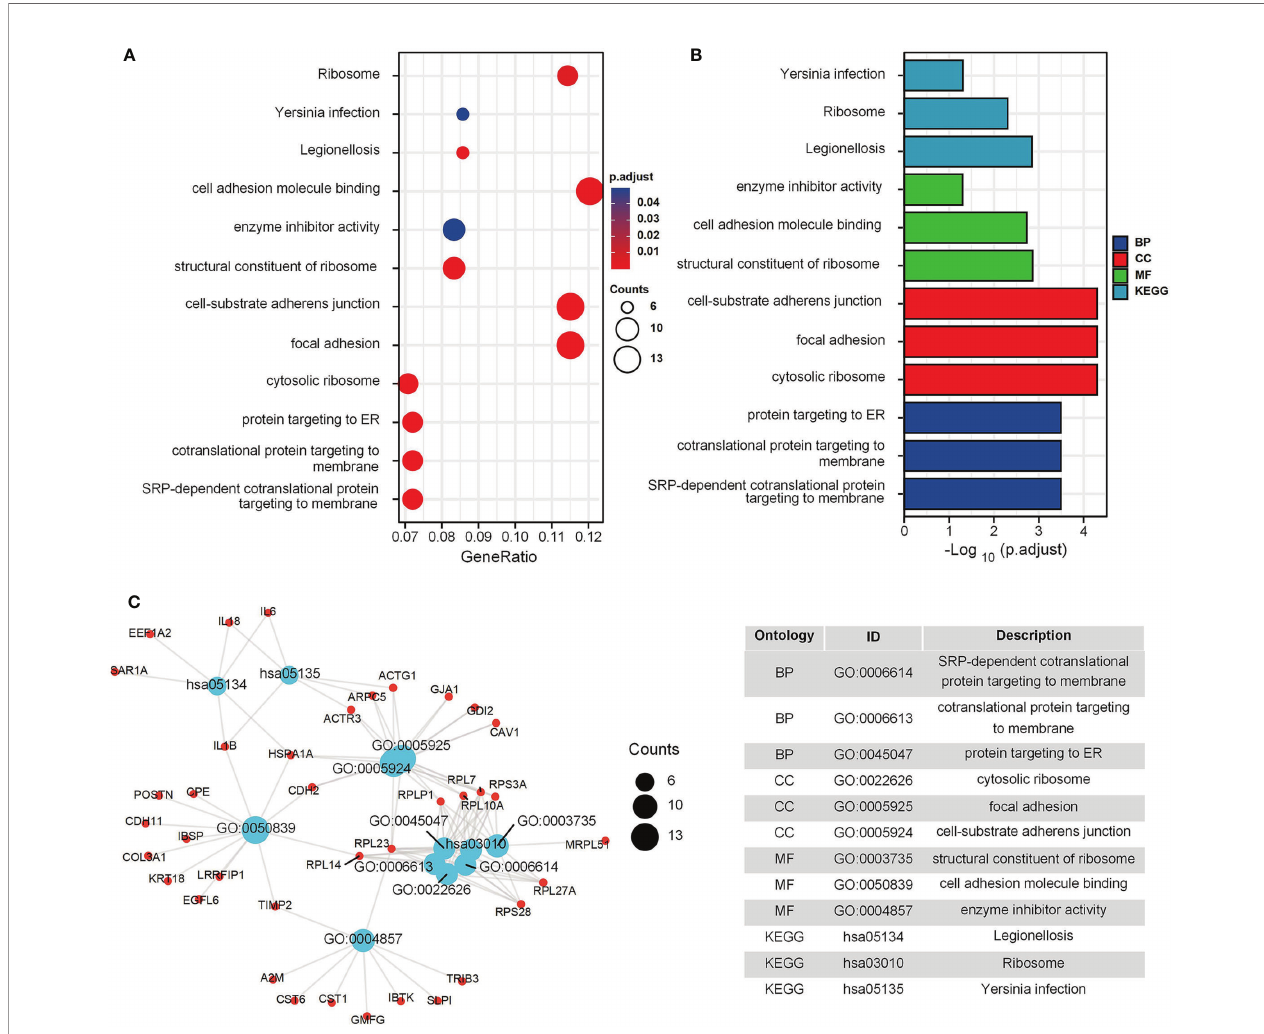
FIGURE 2 | GO and KEGG enrichment analysis in GEO cohort. (A) The bubble graph of clusterPro fi ler package for GO and KEGG enrichment analysis; the bubble size represents the number of gene enrichment, and color represents signi fi cance in GSE42352 data set. (B) The bar graph of clusterPro fi ler package for GO and KEGG enrichment analysis; length represents signi fi cance in GSE42352 data set. (C) A function enrichment network in GSE42352 data